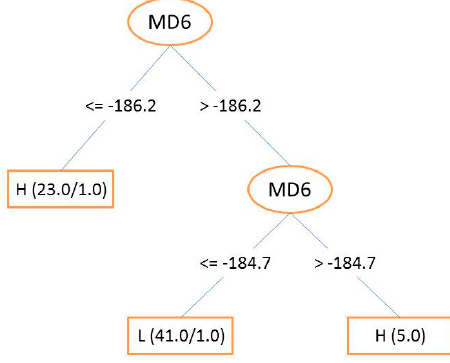
Figure 2. Decision tree for TIBO derivatives.